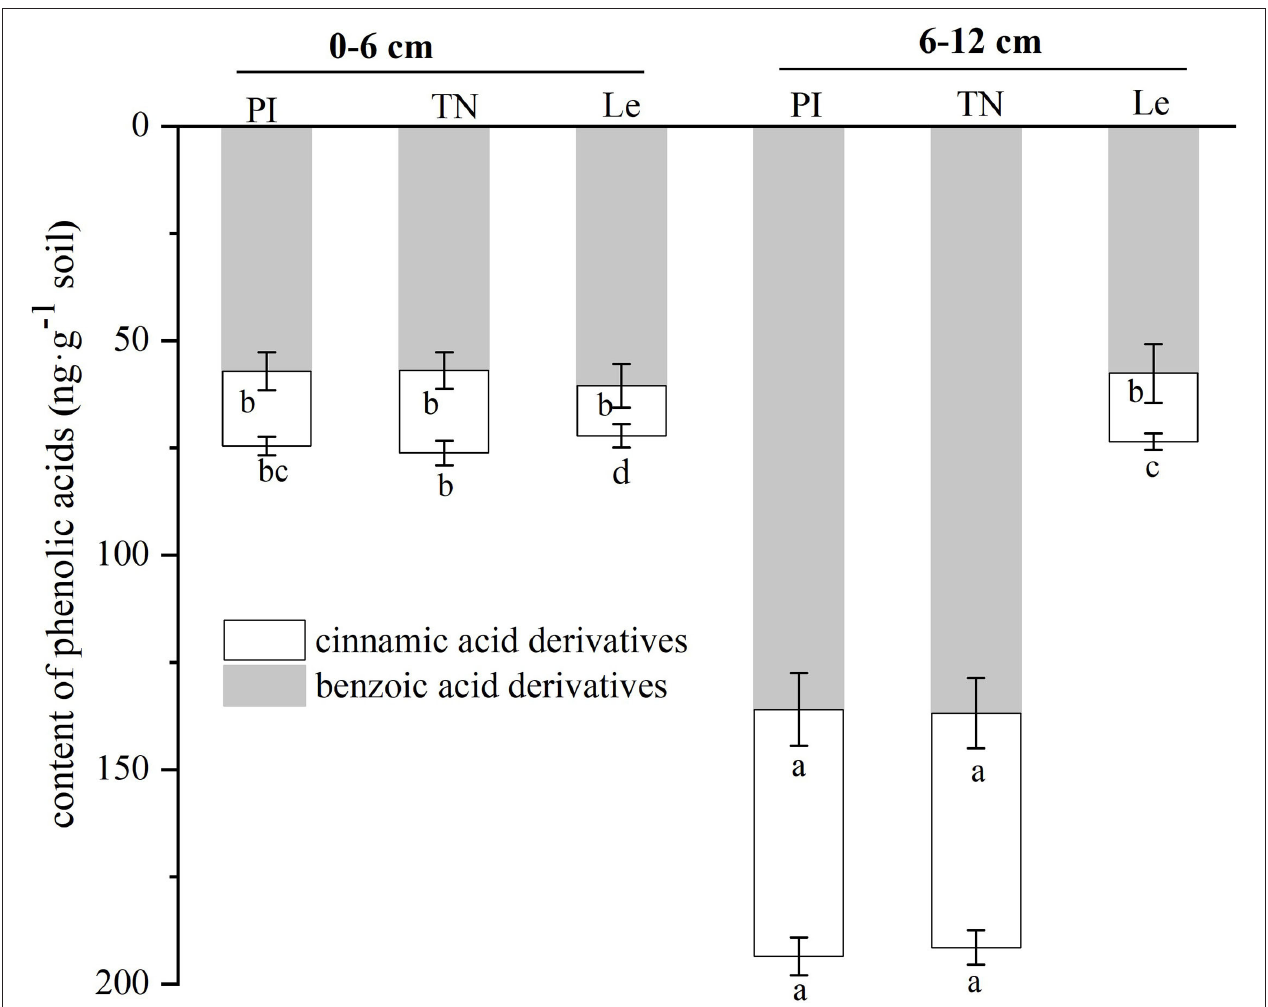
FIGURE 4 | Contents of benzoic acid derivatives and cinnamic acid derivatives in two soil circles of three rice cultivars. PI: allelopathic rice PI312777, TN: allelopathic rice Taichung Native1, and Le: non-allelopathic rice Lemont. Error bars indicate standard deviation. Significant differences ( p < 0.05) between rice cultivars were indicated by different lowercase letters, according to Tukey’s honestly significant difference